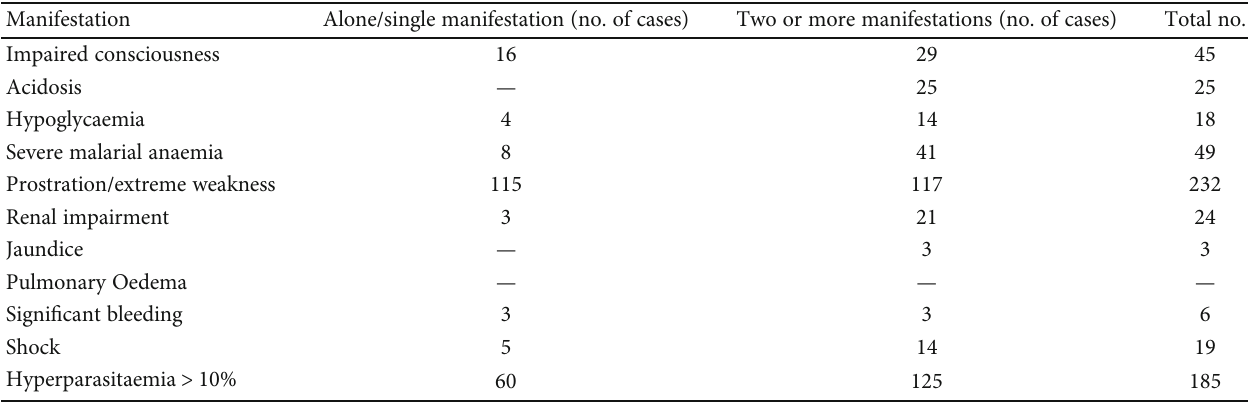
Table 4: Patient manifestation for severe malaria during admission in Arba Minch General Hospital from September 2015 to August 2018, n = 387 .